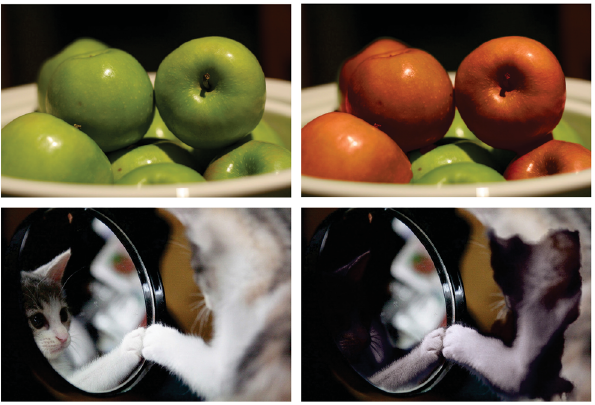
Fig. 11 Failures. Object detection failures (above) or improper matting (below) may cause unsatisfactory